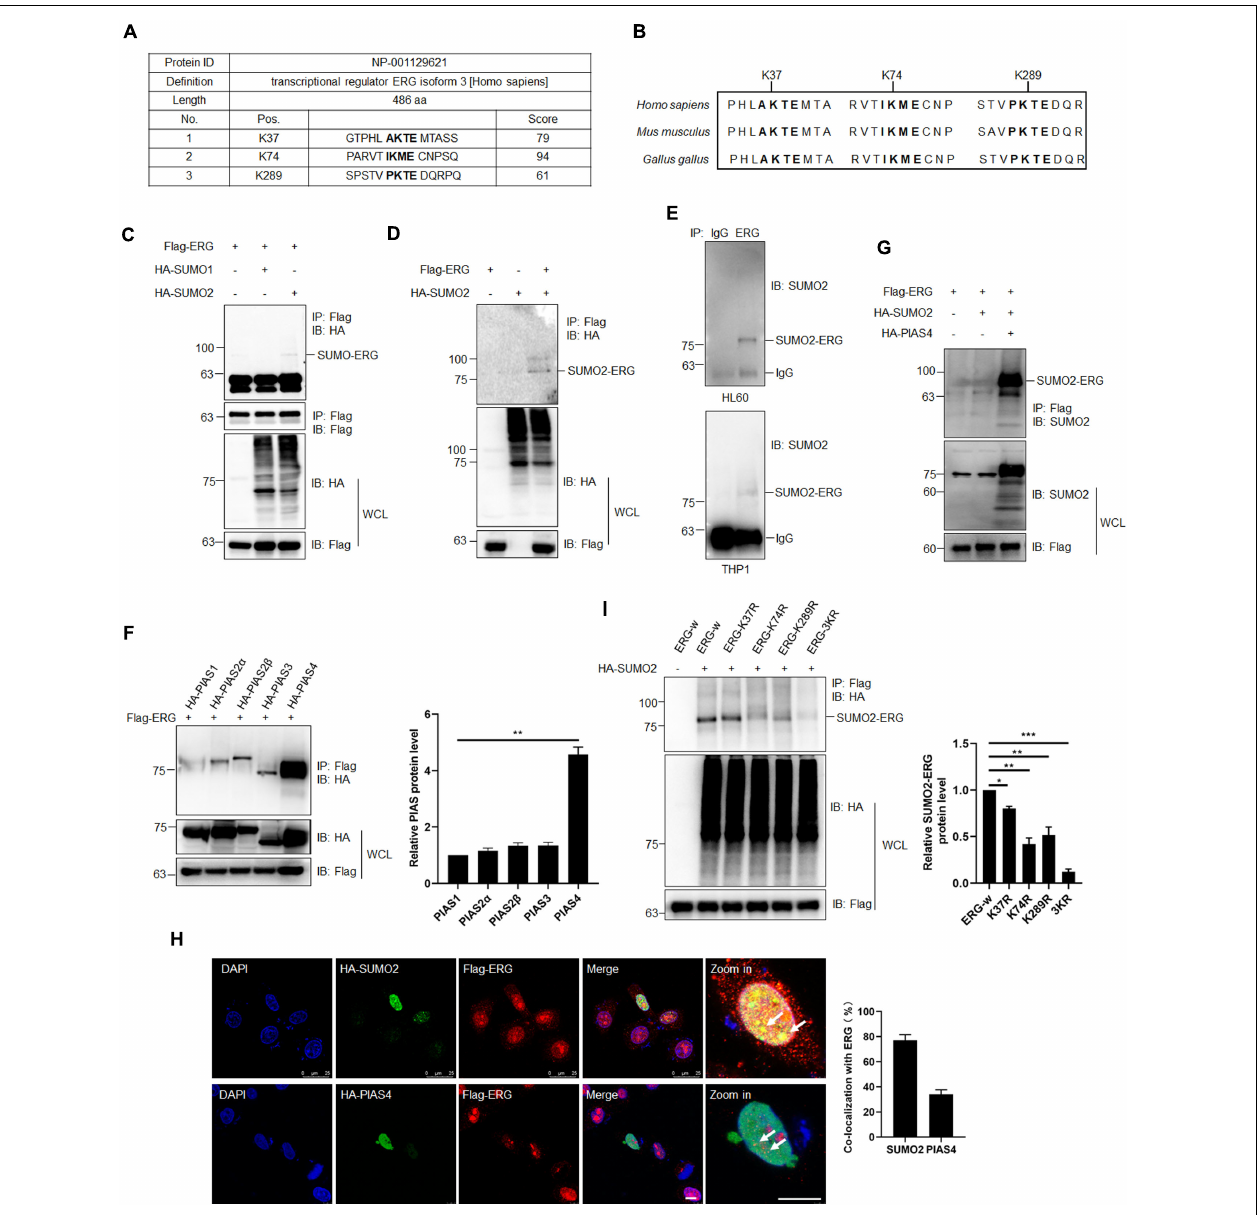
FIGURE 3 | ETS-related gene SUMOylation is dynamically regulated by SUMO2 and PIAS4. (A) The predicted SUMOylation sites of ERG by online software (www.abcepta.com/sumoplot). (B) The potential SUMOylation sites were highly conserved in various species. (C) ERG is mainly SUMOylated by SUMO2 in HEK293T cells. The indicated plasmids were transfected into HEK293T cells, and the cell lysates were detected by IP with anti-Flag antibody, followed by IB with anti-HA antibody. The whole cell lysates (WCL) were detected by IB with anti-Flag and anti-HA antibodies. (D) SUMO2 promoted the SUMOylation of ERG. The indicated plasmids were transfected into HEK293T cells, and the cell lysates were detected by IP with anti-Flag antibody, followed by IB with anti-HA antibody. The WCL were detected by IB with anti-Flag and anti-HA antibodies. (E) ERG was SUMOylated by endogenous SUMO2. The IP with IgG or ERG from HL60 (upper) and THP1 (bottom) cell lysates were detected by IB with anti-SUMO2 antibody. (F) PIAS4 was the major E3 ligase of ERG. The indicated plasmids were transfected into HEK293T cells, and the IP with Flag from cell lysates were detected by IB with anti-HA antibody. The WCL were detected by IB with anti-HA or anti-Flag antibodies (left). The results of quantitative analysis of IP-western are shown in the right panel ( n = 3 repeats/group, one-way ANOVA, ** p < 0.01). (G) PIAS4 enhanced the SUMOylation of ERG. The indicated plasmids were transfected into HEK293T cells, and the IP with Flag from cell lysates were detected by IB with anti-SUMO2 antibody. The WCL were detected by IB with anti-SUMO2 or anti-Flag antibodies. (H) ERG colocalized with SUMO2 and PIAS4 in the nucleus. The indicated plasmids were transfected into HEK293T cells, and cells were harvested for immunofluorescence staining with indicated antibodies (left). The results of quantitative analysis of co-localization are shown in the right panel ( n = 3 repeats/group, Student’s t -test). DAPI (blue) was used to show nuclei. The scale bar is 10 µ m. (I) K37, K74, and K289 were the major SUMOylation sites of ERG. Wild-type or mutant Flag-ERG and HA-SUMO2 were transfected into HEK293T cells, and the IP with Flag from cell lysates were detected by IB with anti-HA antibody. The WCL were detected by IB with anti-HA or anti-Flag antibodies (left). The results of quantitative analysis of IP-western are shown in the right panel ( n = 3 repeats/group, one-way ANOVA, * p < 0.05, ** p < 0.01, *** p < 0.001).